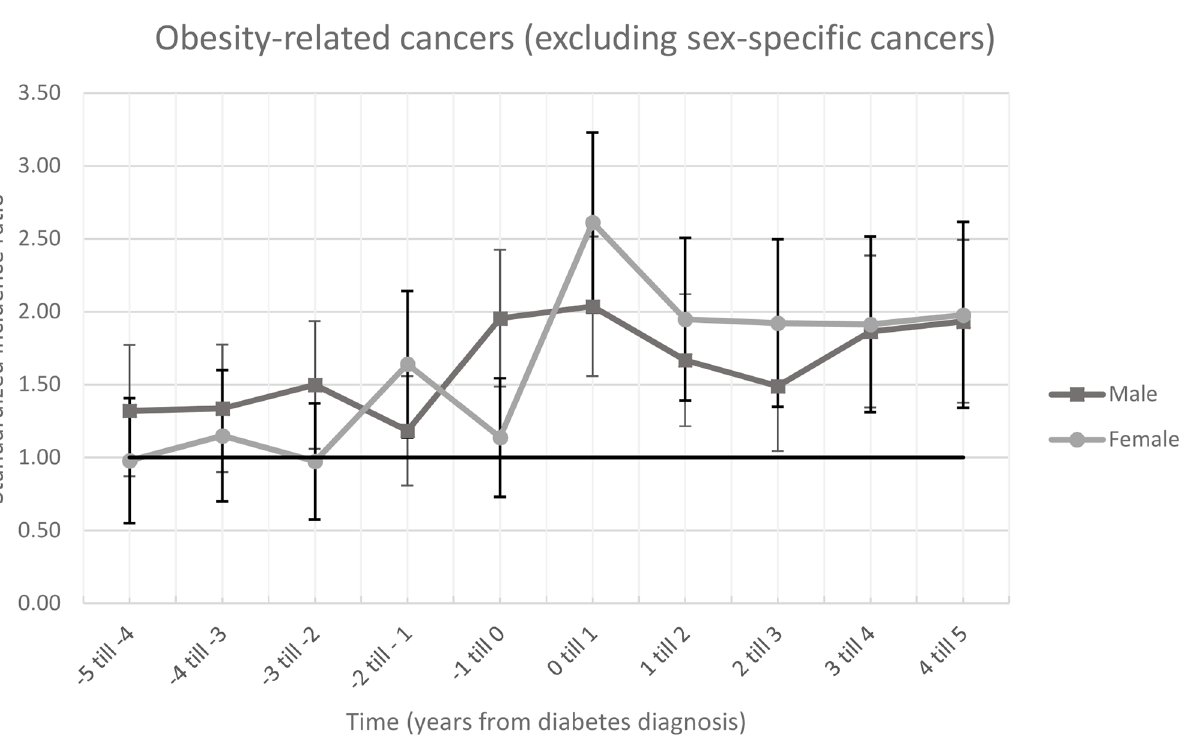
Fig 2. Standardized incidence ratio with 95%CI bars of obesity-related cancer excluding sex-specific cancers. The horizontal line is 1.00 and means that the was no differences between the ZODIAC population and the general population.